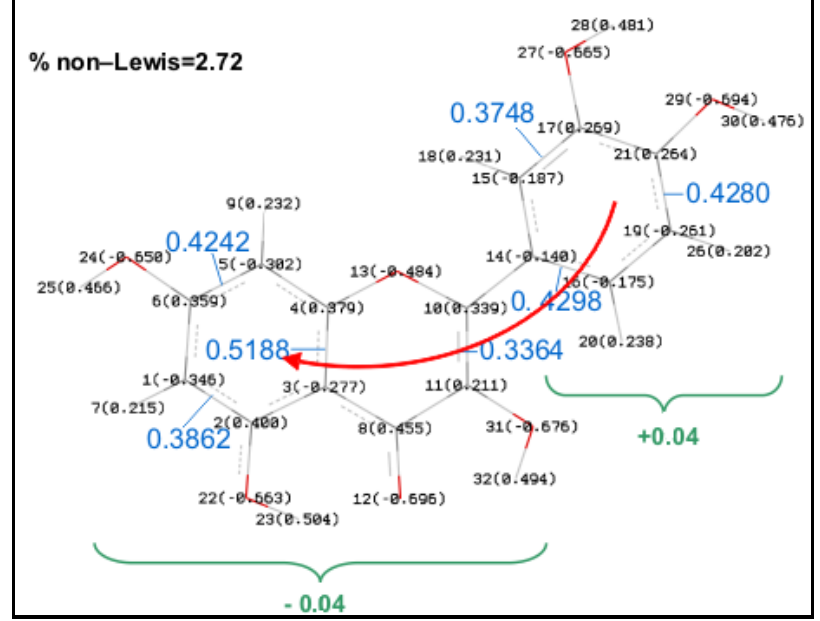
Figure 10. NBO analysis of charge delocalization in molecule XIII (quercetin). Parenthesized values for each atom indicate NBO charges, values in blue indicate occupancy of antibonding orbitals (BD*) for each bond, values in green indicate sum of NBO charges for each moiety (B ring and A + C), red arrow indicate mechanism of charge